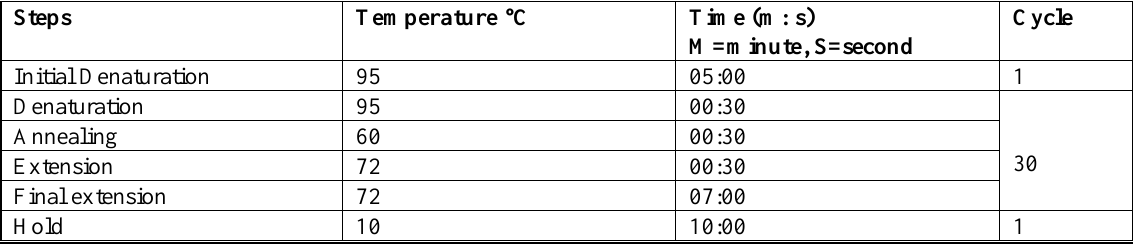
Table 1. PCR amplification program